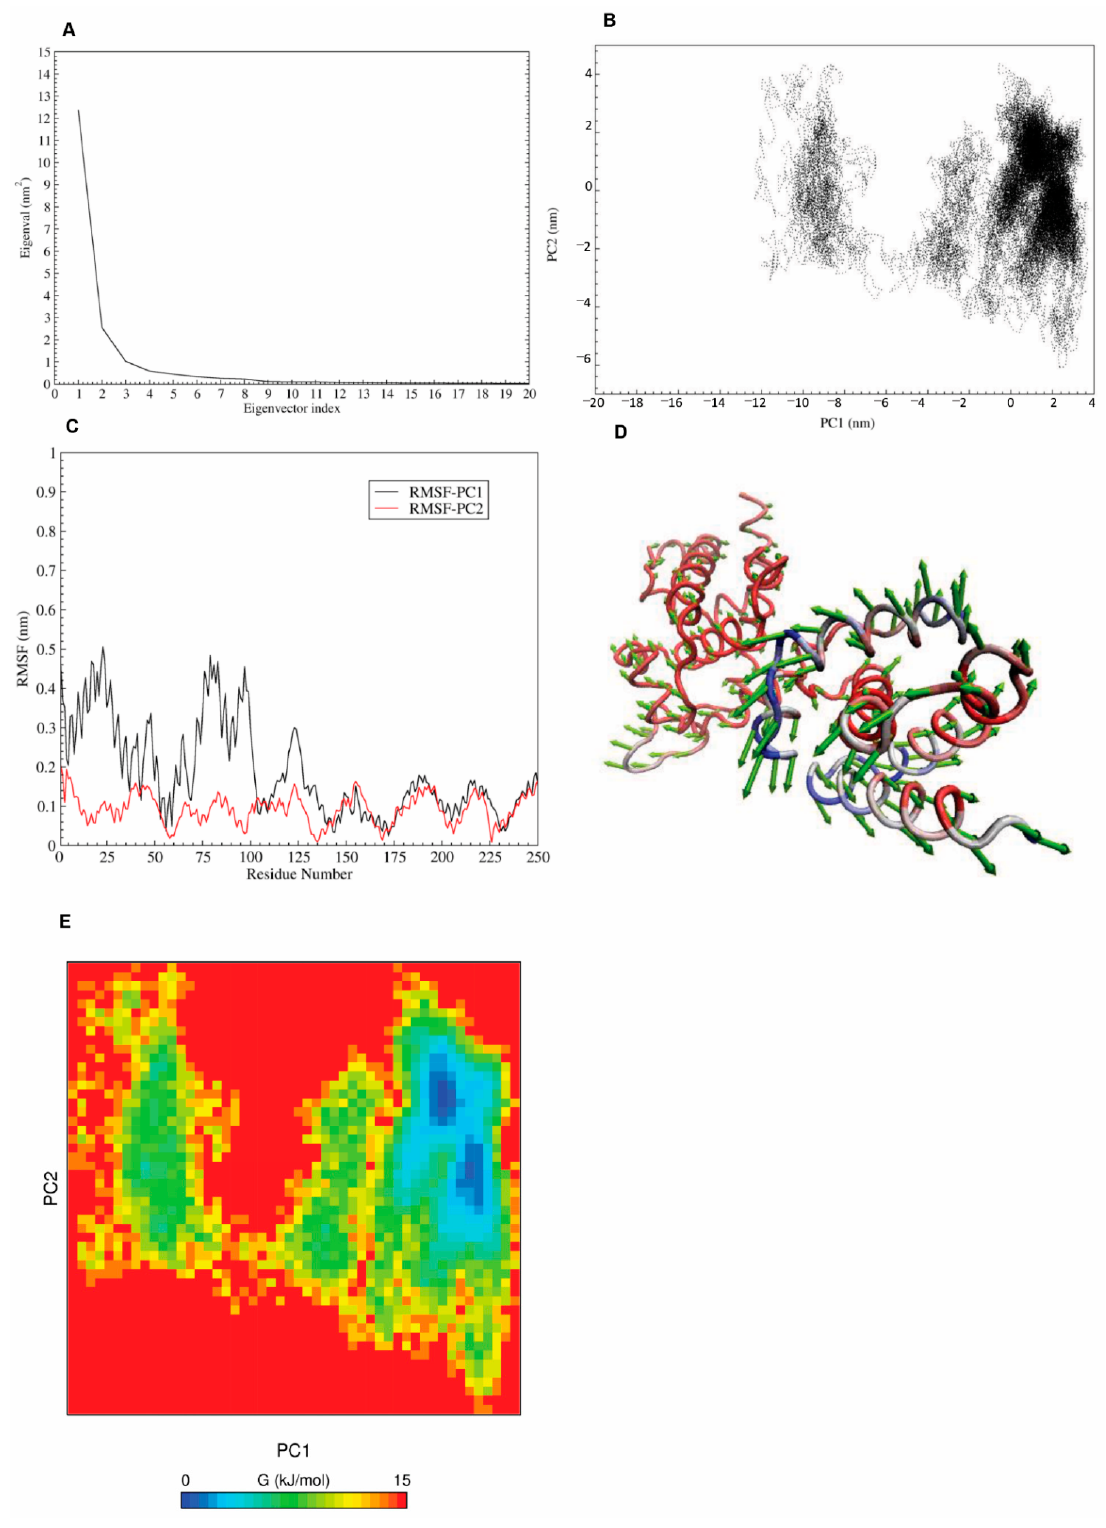
Figure 4. Confirmation of BRF2 (cid:48) s conformational changes using the PCA method. ( A ) The plot of eigenvalues obtained from the C α covariance matrix built from MD trajectories. ( B ) Principal component analysis of the BRF2 protein. ( C ) Residue- based mobility plot of BRF2 in modes 1 and 2. ( D ) Porcupine plots of the PCA analysis for PC1, depicting the movement and altitude of the C-alpha atoms throughout the 100 ns of simulation. ( E ) Free energy landscape of BRF2